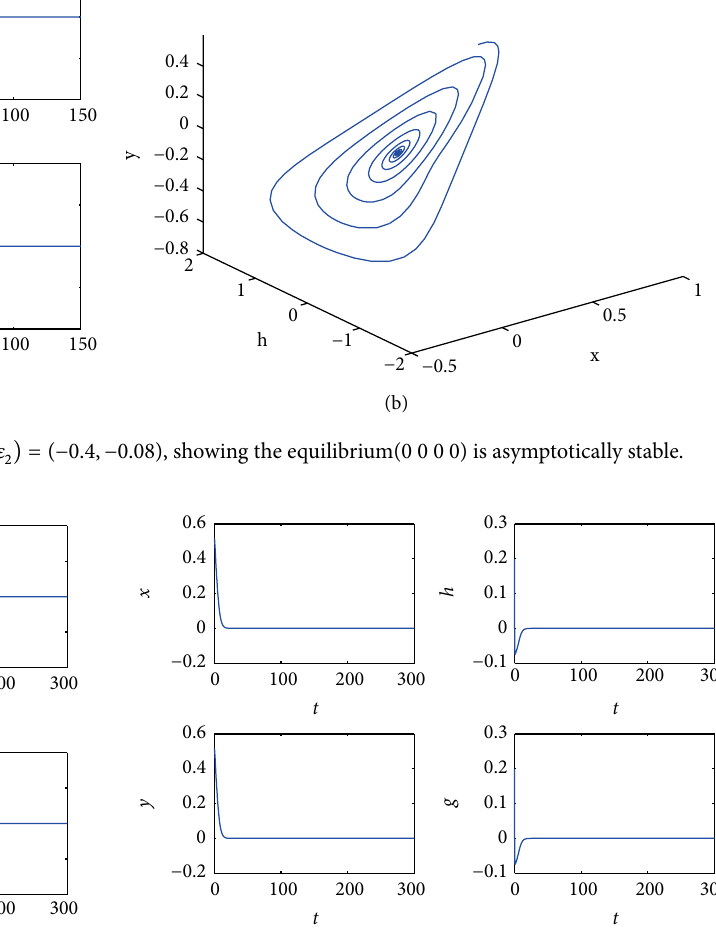
Figure 5: Simulated solution of Equation (2) for 𝑃 = 0.001, 𝑟 = 4/3,𝑐 = 94,𝜏 = 1000 : the equilibrium (0 0 0 0) is asymptotically stable.